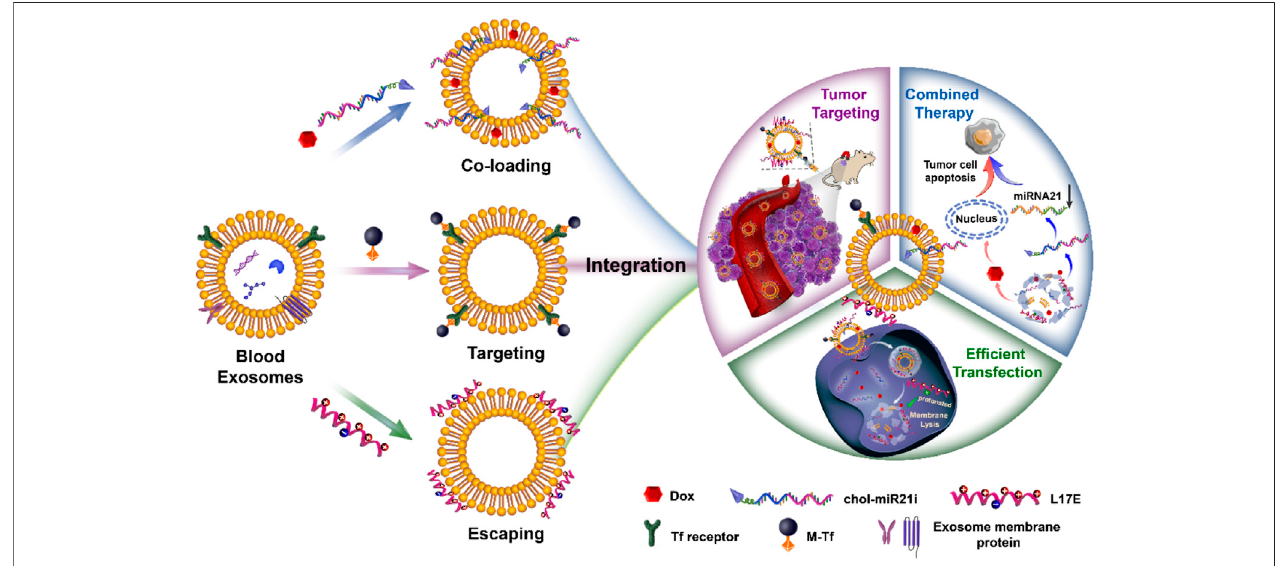
FIGURE 1 | The preparation of engineered blood exosomes and their mechanism for the combined antitumor therapy with nucleic acid drugs and chemotherapeutics (Zhan et al., 2020).